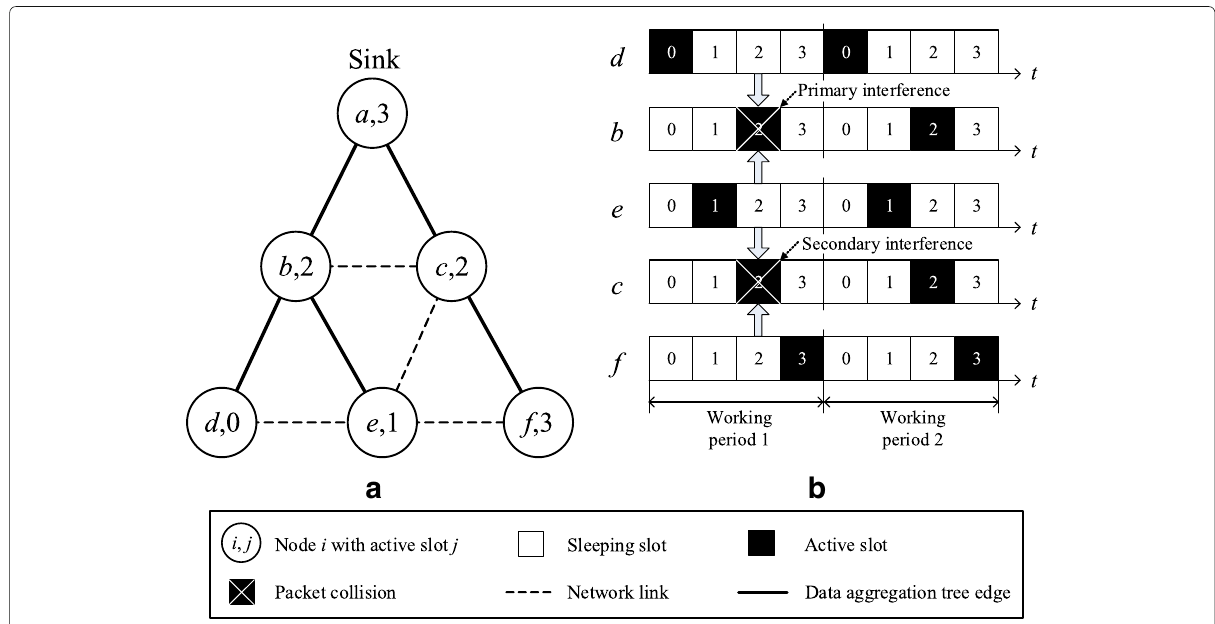
Fig. 1 An example of collision in data aggregation scheduling in duty-cycled WSNs. a Network topology. b Duty-cycled